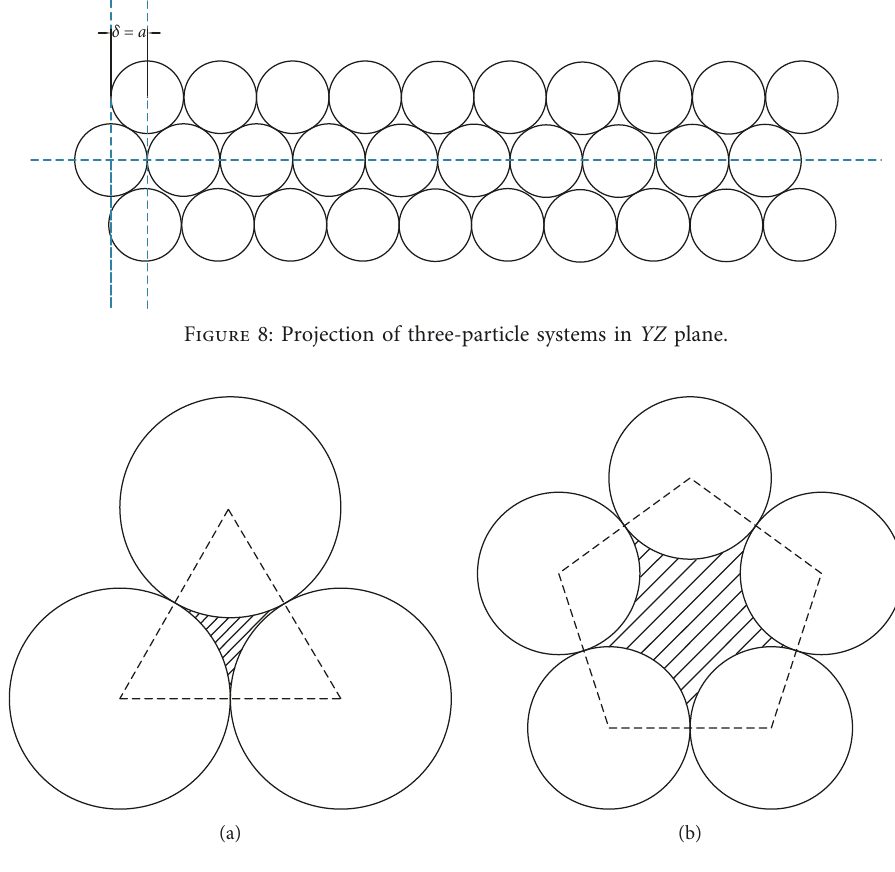
Figure 9: Other particle combinations. (a) The three-particle system. (b) The five-particle